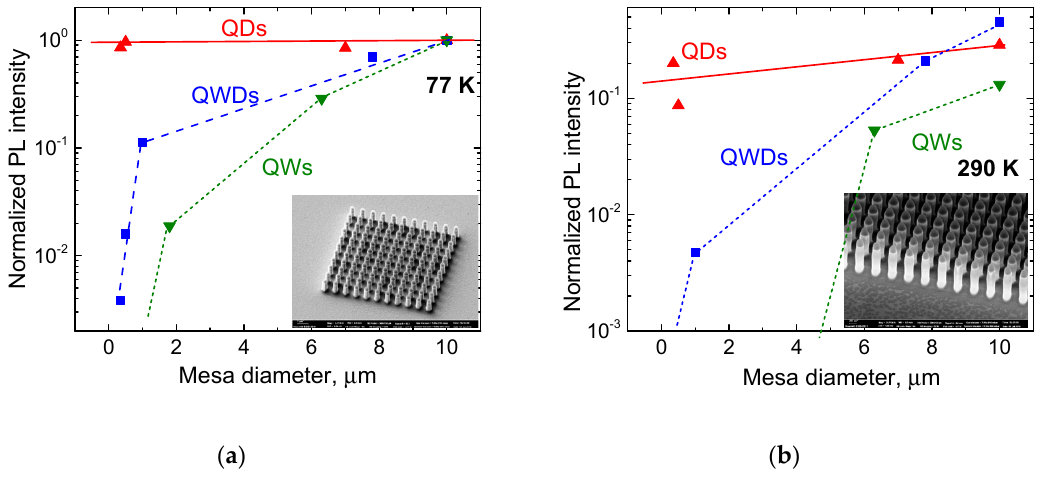
Figure 8. PL intensity mesas with QDs, QWDs, and QWs as a function of mesa diameter measured at 77 K ( a ) and 290 K ( b ). Insets: microscopic images of mesa arrays taken with different magnification.